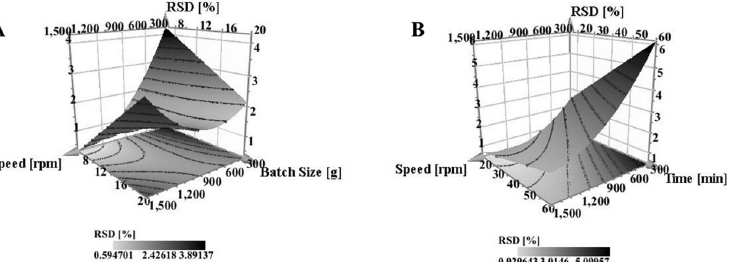
Fig 11. Response Surface Model (RSM) Plot of the (A) effect of speed and Batch size on the content uniformity of ibuprofen in the powder mixture while maintaining processing time and air flow at their middle values, (B) the effect of speed and processing time on the content uniformity of ibuprofen in the powder mixture while maintaining air flow and batch size at their middle values.